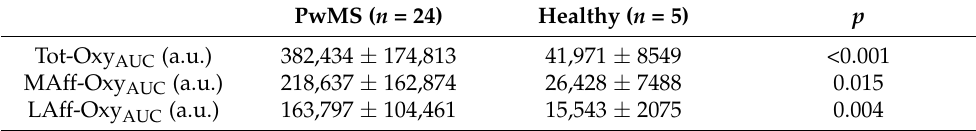
Table 2. Comparison of cortical activation between people with MS and healthy